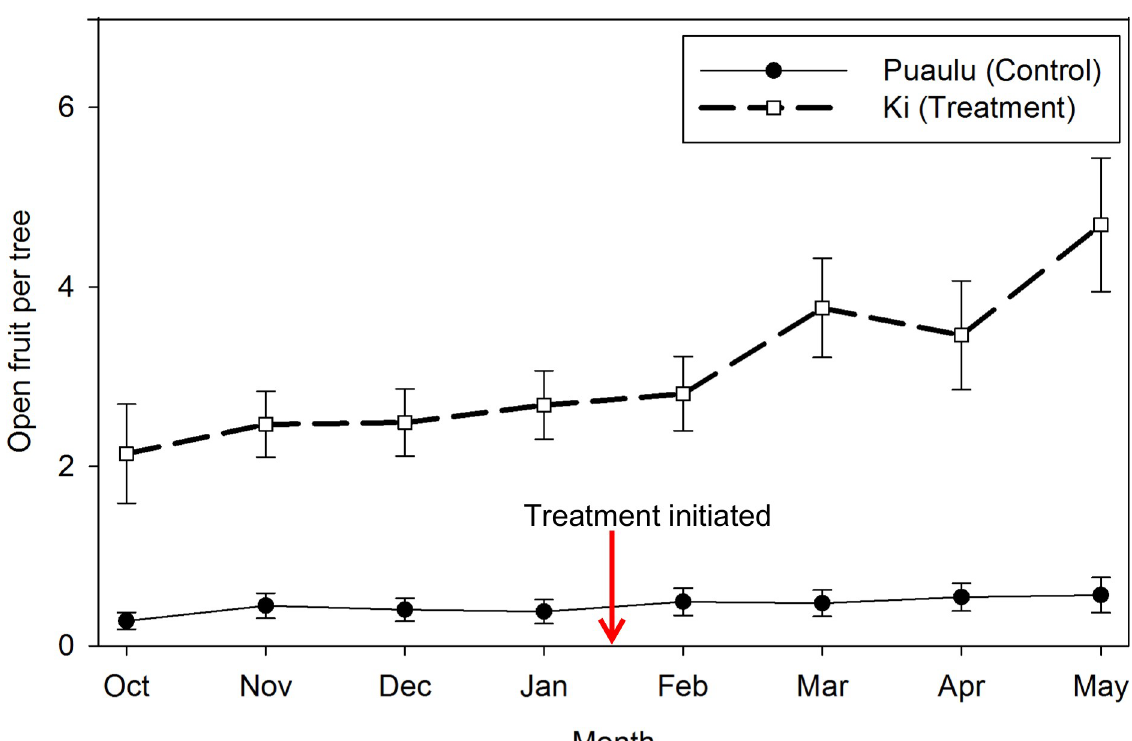
Fig 2. Hau kuahiwi ( Hibiscadelphus giffardianus ) open fruit retention. Fruit retention was observed monthly over four months before and four months during rat control (median ± SE). Rat control was initiated immediately after January data collection.